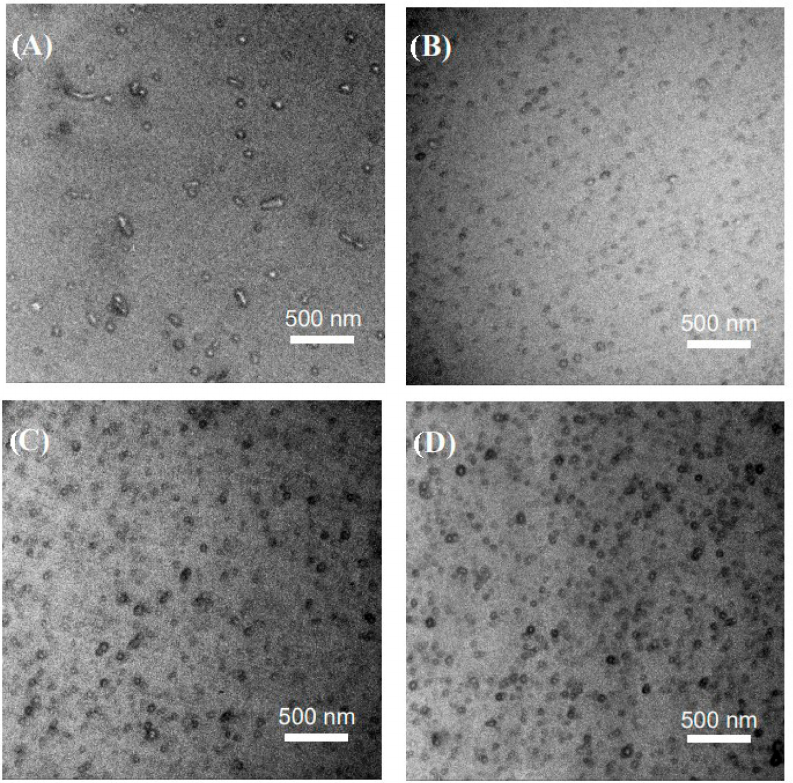
Figure 4. TEM images of epoxy thermosets containing ( A ) 5, ( B ) 10, ( C ) 15 and ( D ) 20 wt% of PCL -b- PE -b- PCL via